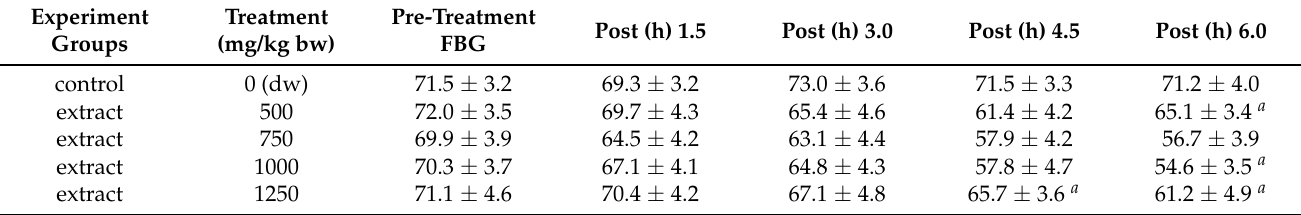
Table 3. Effect of graded dose of t. dioica leave aqueous extract on blood glucose leveles (mg/dL) of normoglycemic rats (mean ± standard deviation) for pre- and post- treatments.